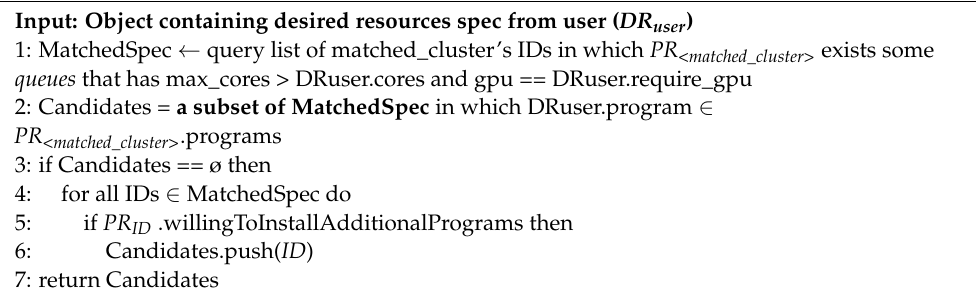
Algorithm 1. Pseudocode of